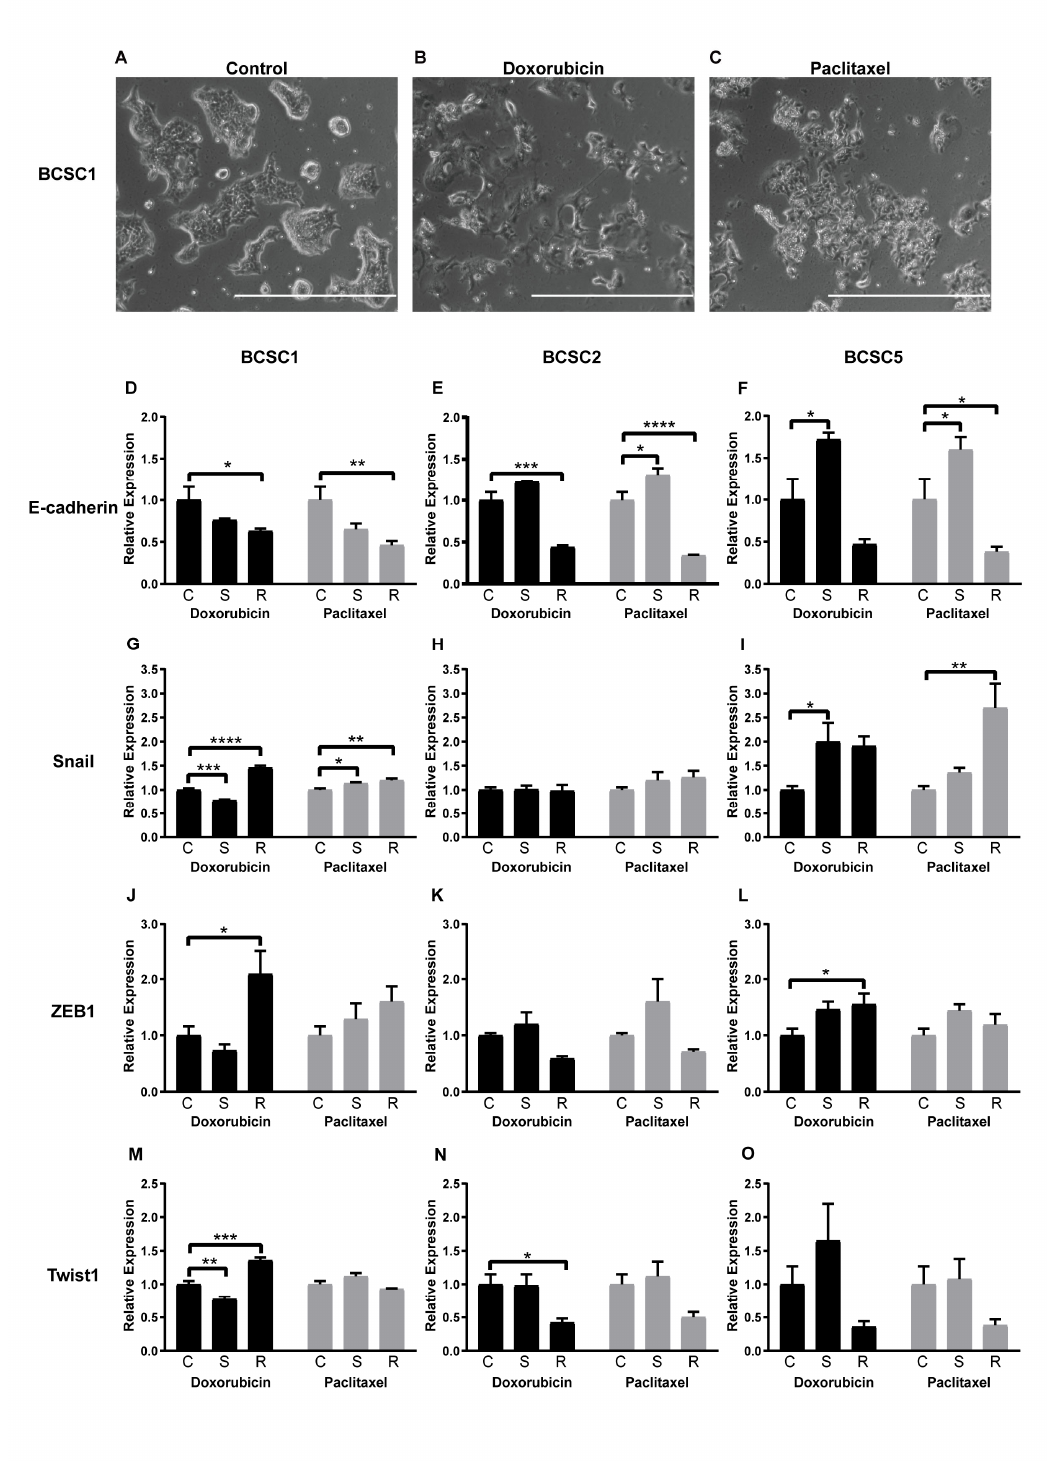
Figure 4. Chemotherapeutic stress changed the cell morphology and the EMT gene expression of the BCSCs at mRNA level. ( A ) Cell morphology of BCSC1. ( B – C ) Morphological changes of BCSC1 exposed to doxorubicin ( B ) and paclitaxel ( C ), scale bar 1000 μ m. ( D – O ) EMT factor expression fold change at mRNA level for surviving (S) and recovered (R) BCSCs from doxorubicin or